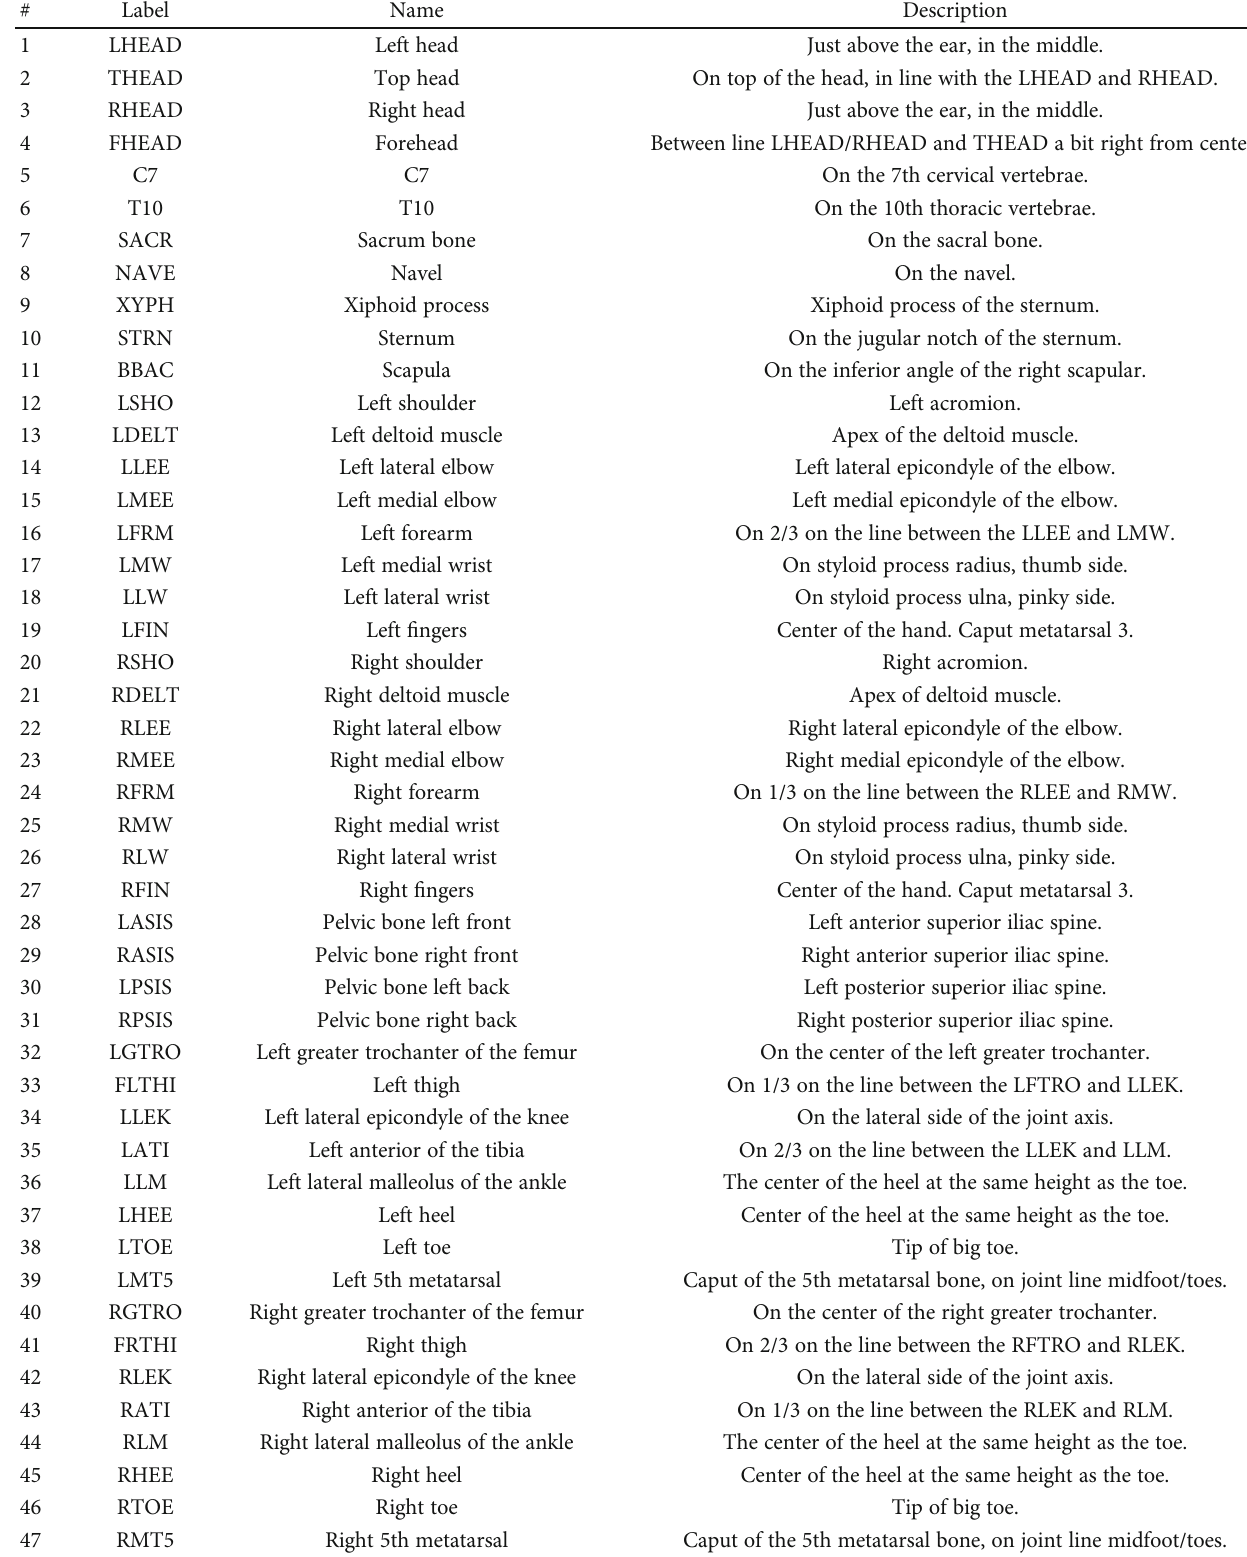
Table 3: 47 marker acronym de fi nitions Moore et al.